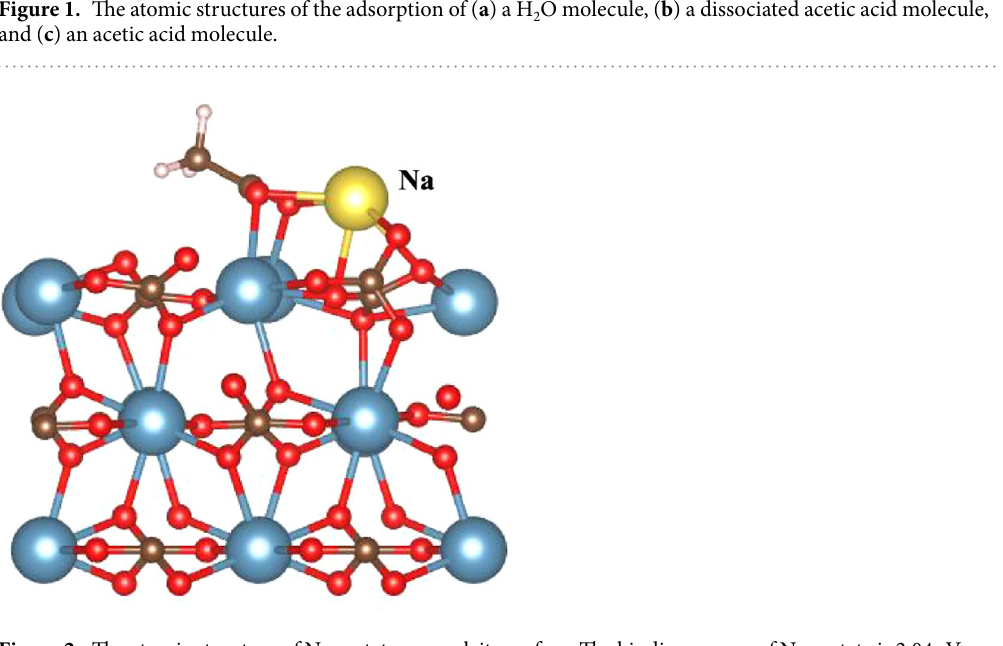
Figure 2. The atomic structure of Na acetate on a calcite surface. The binding energy of Na acetate is 2.04 eV, which is larger than original oil molecule (acetic acid) (2.10 eV vs 1.28 eV). Hence, Na + ions of sea water makes oil molecule more sticker that reduce the crude oil